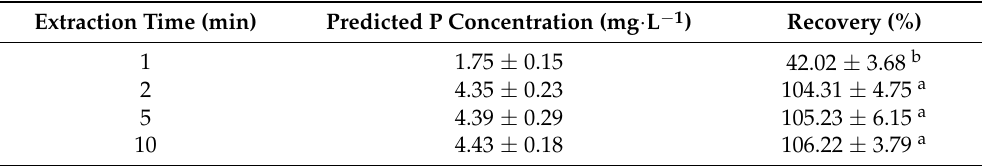
Table 3. Effect of extraction time on extracted soil P using CV of 1 FP suspended in a mixture of 0.5 mL of water and 50 mg of soil.